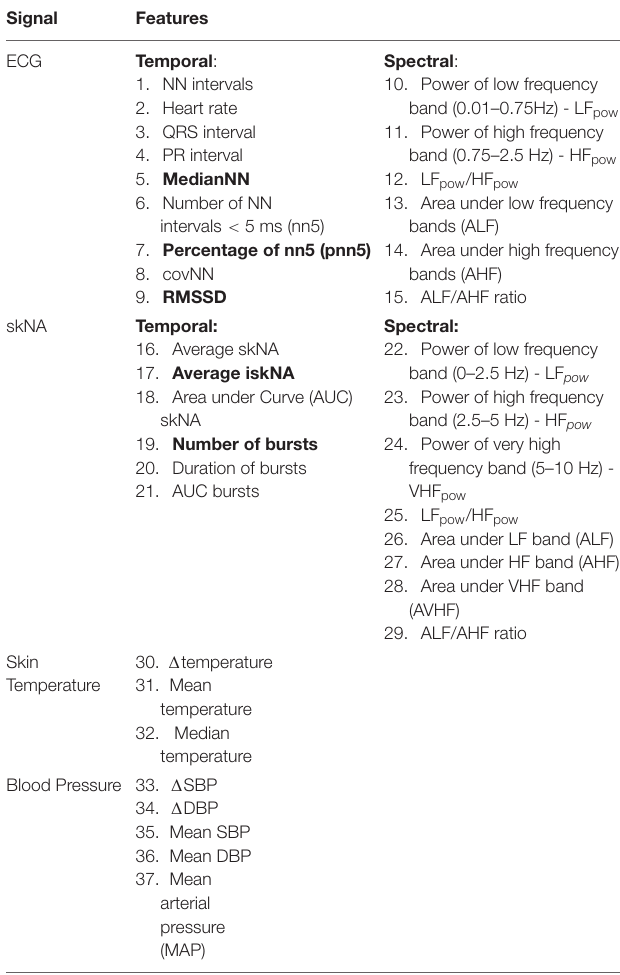
TABLE 1 | 36 features extracted from the different sensors.